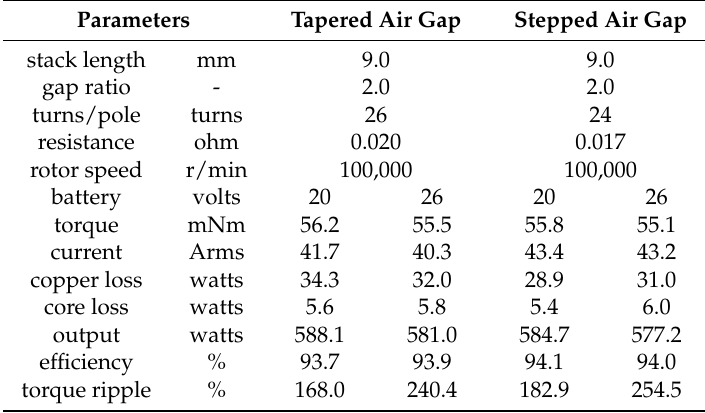
Figure 10. Output power of stepped air gap with respect to switching angles in case of battery voltage: ( a ) 20 V; ( b ) 26 V. Table 2. Summary of electrical dynamic performance.